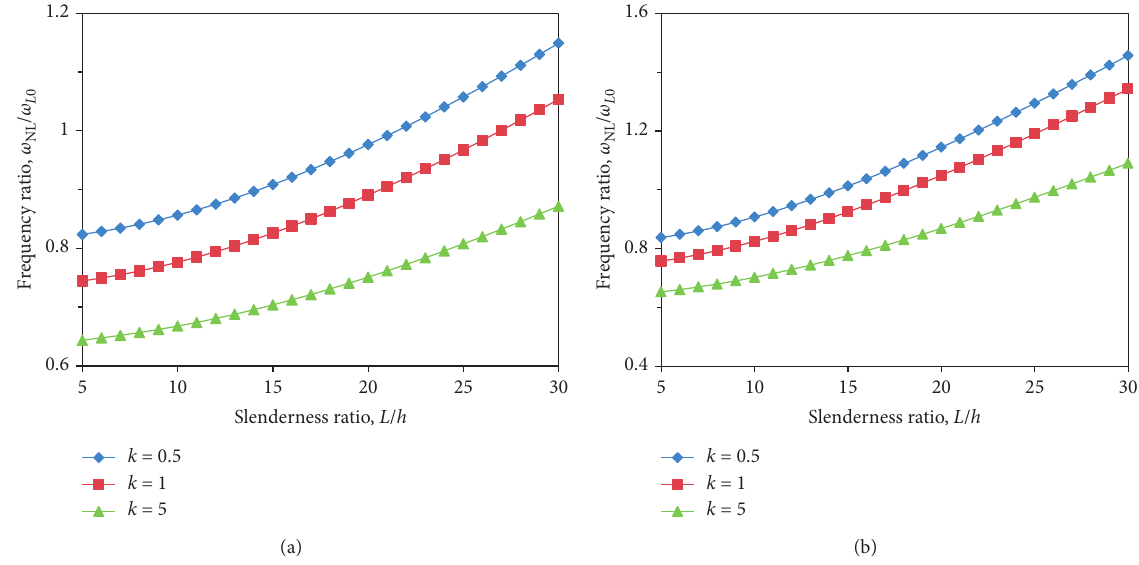
Figure 13: The variation of the frequency ratios of the FG nanobeams to the slenderness ratio for β � 0 . 01, c � 10, and V thickness effect; (b) with thickness